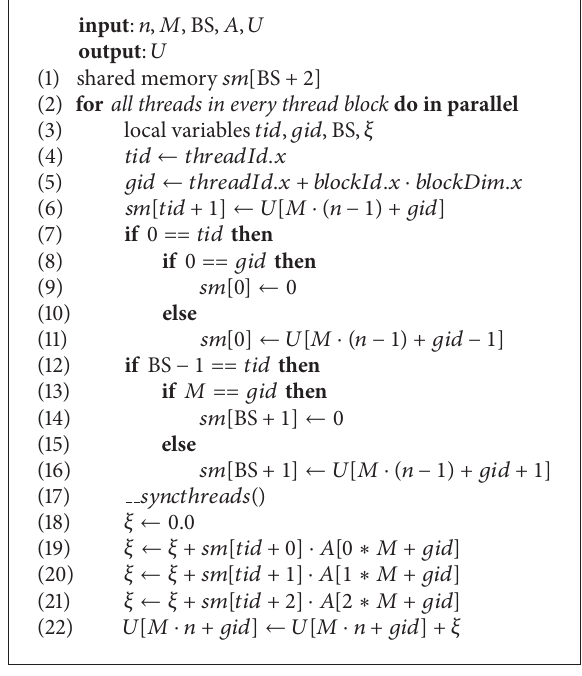
Algorithm 3: CUDA kernel for tridiagonal matrix vector multipli- cation.